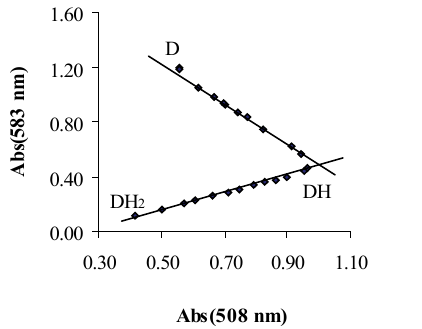
Figure 7. Correlation diagram between the (A values and the corresponding experimental A molecule in high pH range at λ =508 nm by applica- tion of Eq. 4.